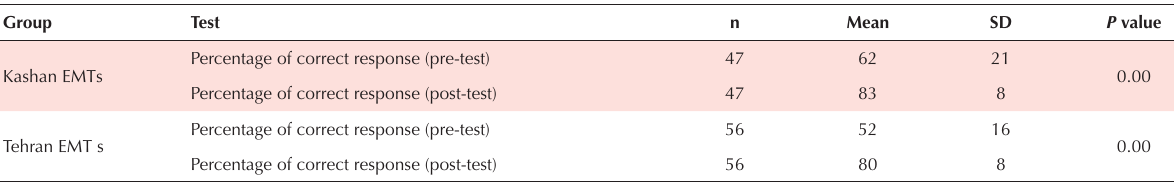
Table 3. Evaluation of the participants after the implementation of the training plan